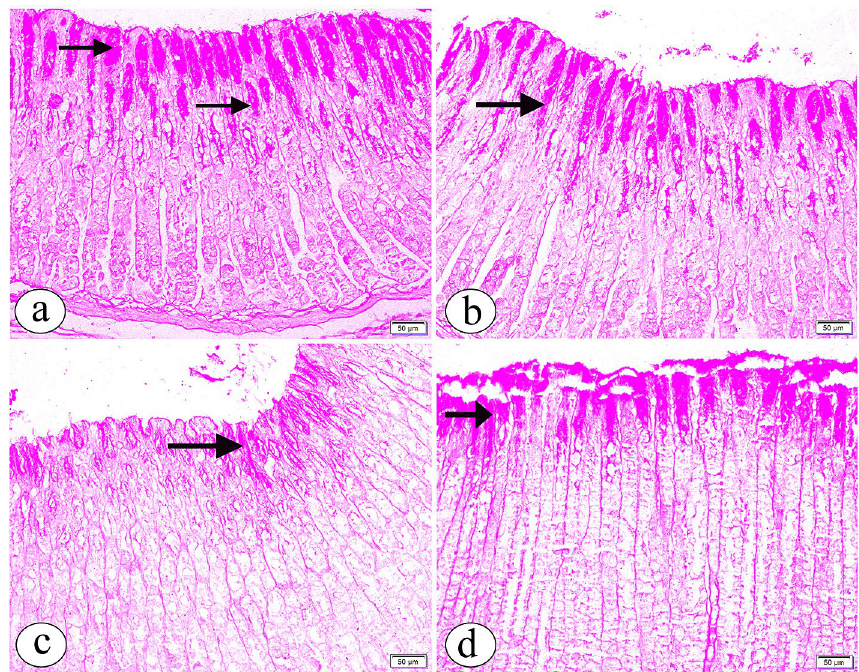
Figure 2. The photomicrographs of the sections in the glandular portion of the stomach in ( a ) the group Ӏ showing a strong positive Periodic Acid Schiff (PAS) reaction in the lining epithelium and neck cells (arrow) is noticed. ( b ) the group ӀӀ showing a strong positive PAS reaction (arrow) more or less than in group Ӏ . ( c ) the group ӀӀӀ showing a decrease in PAS reaction in the lining epithelium and neck cells (arrow). ( d ) the group Ӏ V showing a restoration of the positive PAS reaction in the lining epithelium and neck cells (arrow). (PAS, × 200, scale bar = 50